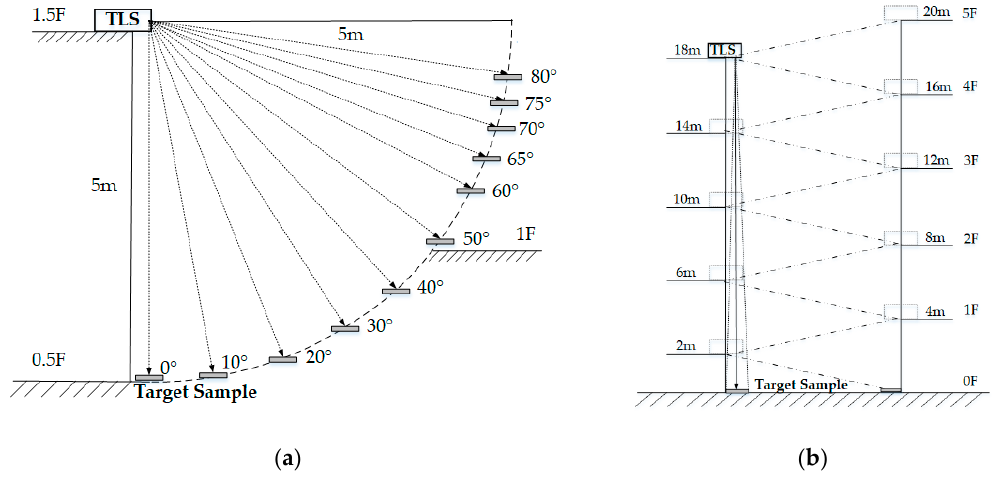
Figure 2. ( a ) The sketch of incidence angle experiments: the laser scanner is placed on the stair landing of a staircase and the sand samples are laid on eleven horizontal platforms. These eleven platforms have a fixed distance (5 m) from the scanner centre but different incidence angles varying from 0° to 80°. ( b ) The sketch of the distance experiments: the distance from the laser scanner to the target samples varied in steps of 1 m from 1 to 4 m and then in steps of 2 to 20 m by setting up the scanner at different floors. The sand samples were placed on the ground floor.